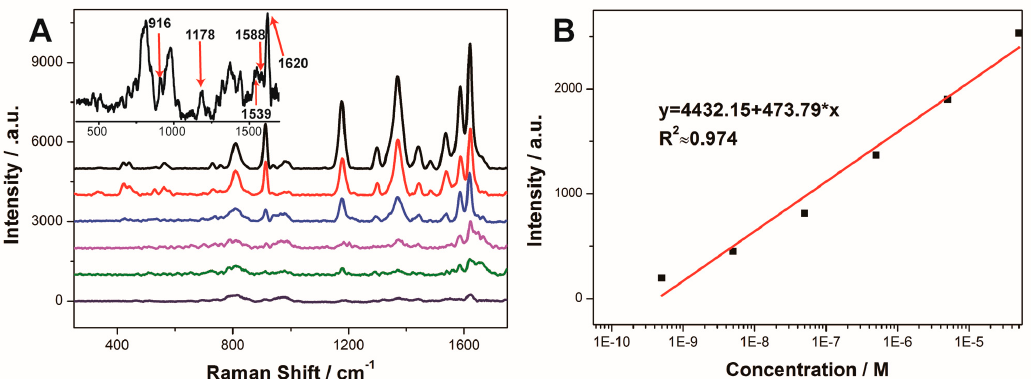
Figure 3. SERS spectra of CV with different concentrations in 200 μ M Au NP@MoS 2 QDs aqueous solution ( A ) and the corresponding quantitative curves (using the band at 1620 cm − 1 , B ). Insert: SERS spectrum of 0.5 nM CV in the 200 μ M nanocomposite suspension.